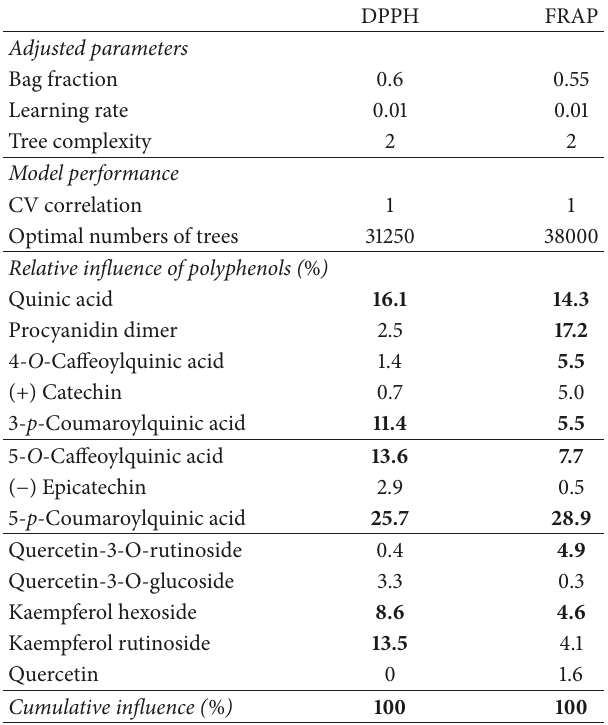
Table 3: Adjusted parameters, performance, and relative influence (%) of Boosted Regression Trees models for antioxidant capacity (FRAP and DPPH) of quince